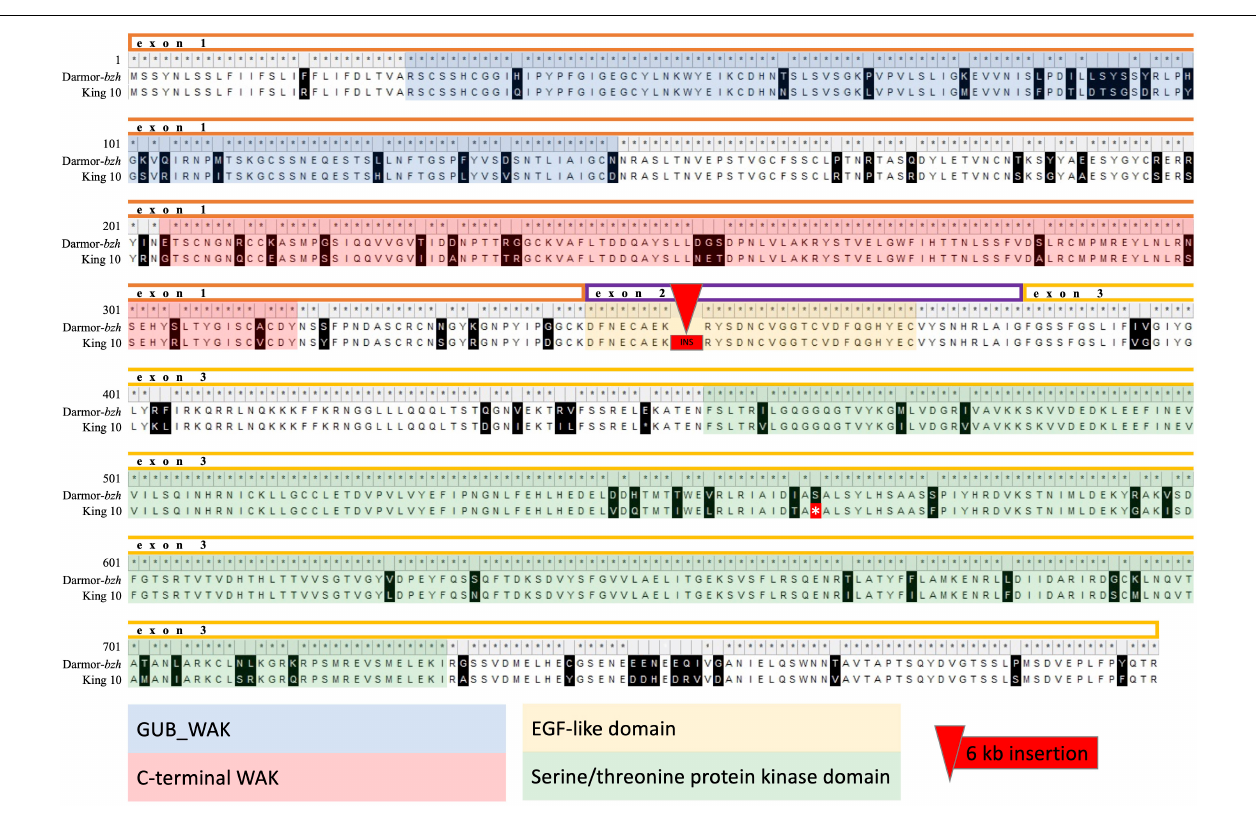
FIGURE 2 | Alignment of the protein sequence of King 10 against the reference Darmor- bzh v10. King 10 is representative for the four parental lines harboring a 6 kb insertion and 202 SNV leading to 92 non-synonymous amino acid changes. Different colors indicate exons and conserved domains. The asterisk indicates a stop